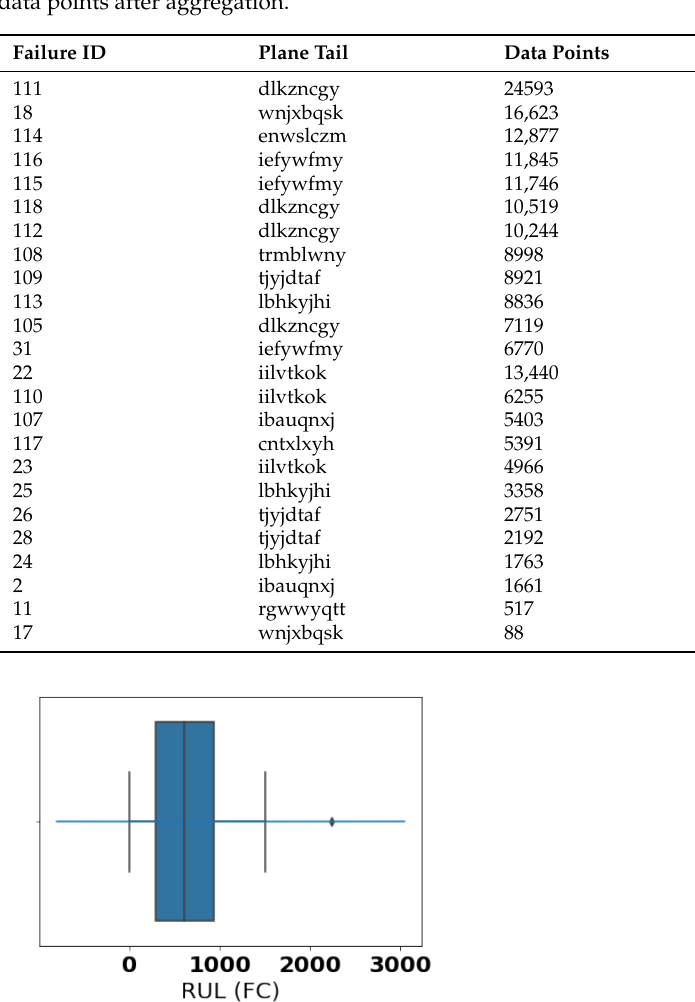
Table 14. The 24 trajectories of the CUs, the number of flight cycles in operation and the number of data points after aggregation.